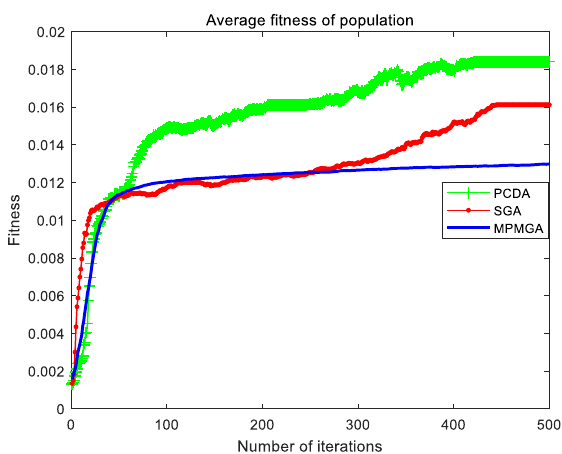
Figure 23. Evolutionary comparison diagram of population average fitness.